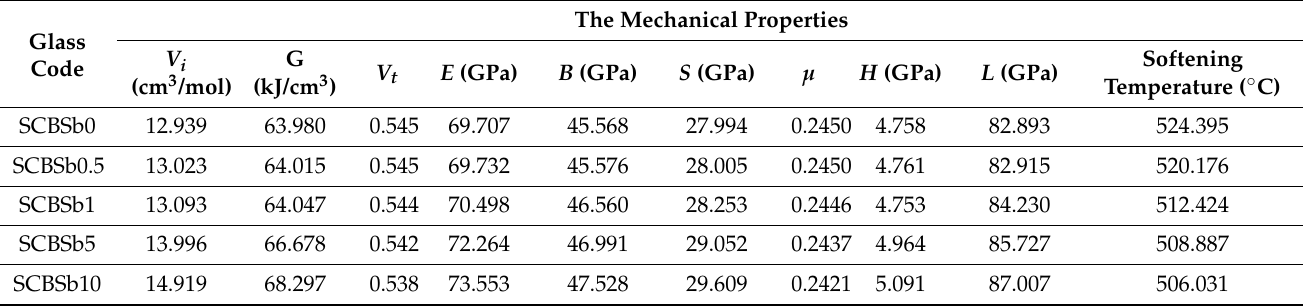
Table 2. The mechanical properties of the investigated